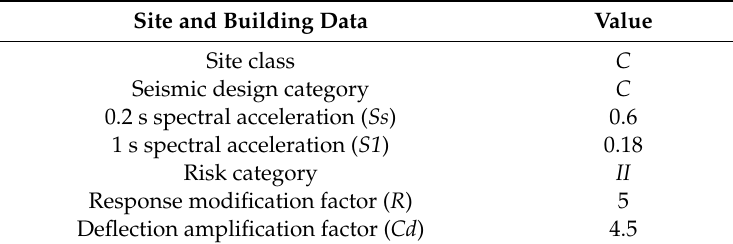
Table 1. Site and Building